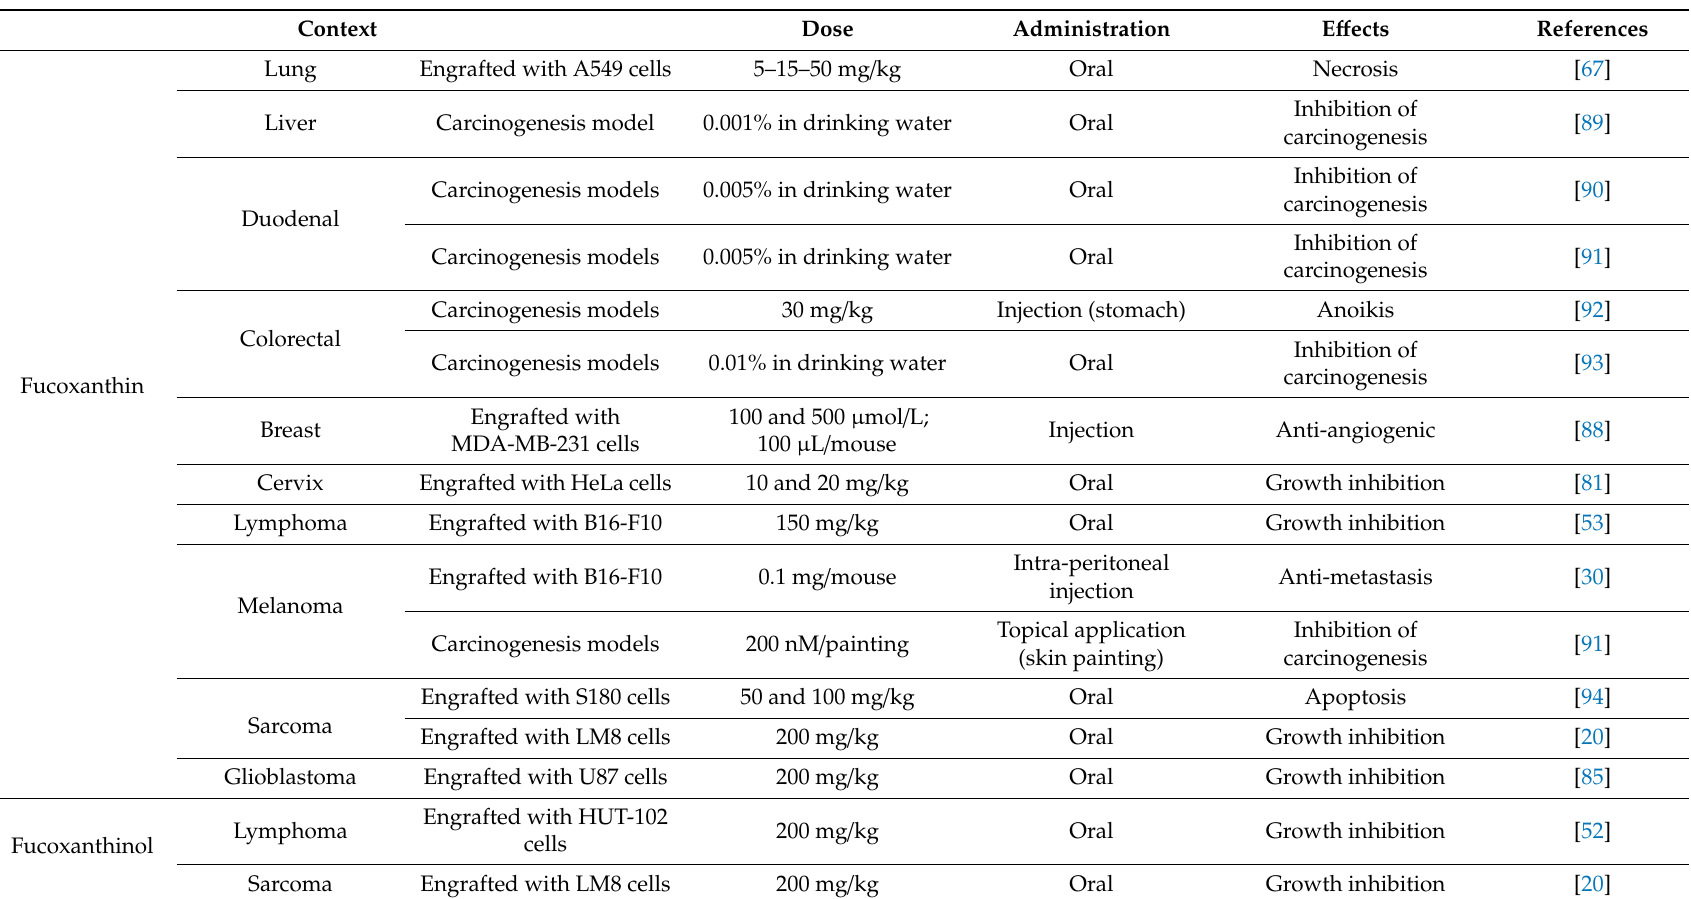
Table 3. E ff ects of fucoxanthin and fucoxanthinol e ff ects on in vivo cancer models